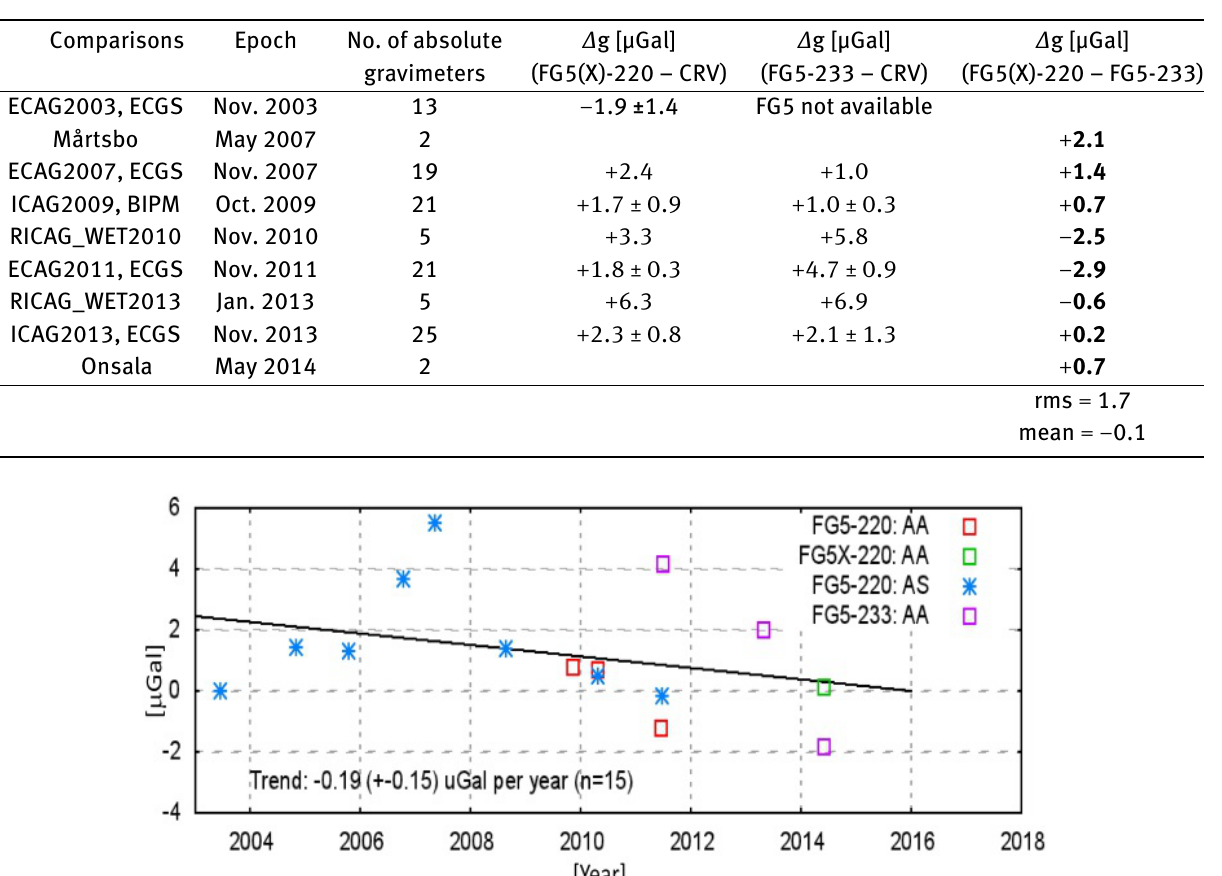
Table 2: Compilation of gravity differences between FG5-233 (LM) and FG5(X)-220 (LUH) within international, regional and local compar- isons. Comparison reference values (CRVs) are defined by all participating qualified gravimeters (ICAG, ECAG) or by the reference gravime- ters of BKG (RICAG). Statistical values (short-term reproducibility of a single instrument) are partly not available. Since 2012 the FG5X-220 (upgrade of FG5-220) has been available.